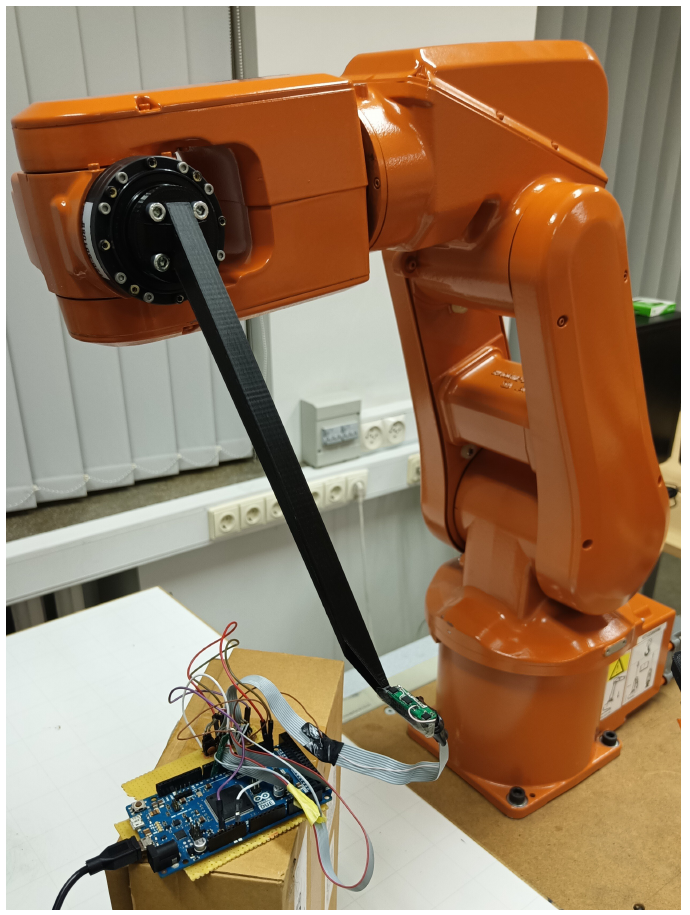
Figure 5. Robotic arm with the sensor fastened to the custom mounting